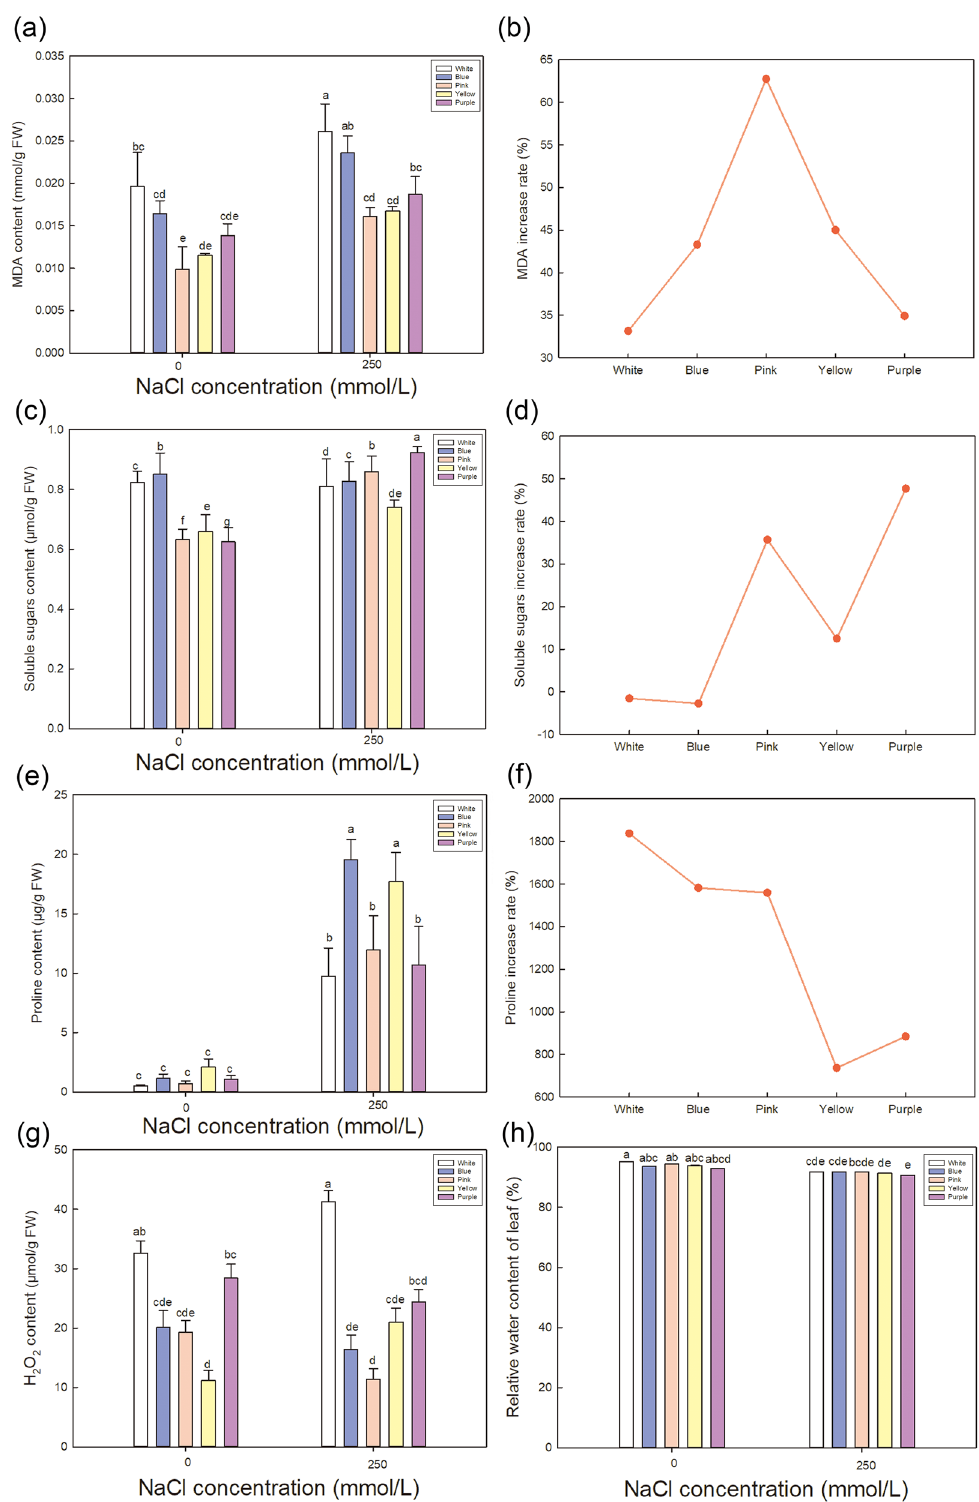
Figure 6. Effect of NaCl stress on MDA, soluble sugars, proline contents, H 2 O 2 and relative water content in the leaves of five varieties of Limonium sinuatum . Contents of MDA ( a ), soluble sugars ( c ), proline ( e ), H 2 O 2 ( g ) and relative water content ( h ) of leaves under control and NaCl treatment in different varieties. The data are means ± SD of five replicates. Different letters indicate significant differences between two groups at P = 0.05 using Duncan’s test with SPSS. The increase rate of MDA ( b ), soluble sugars ( d ) and proline ( f ) are calculated using (value under NaCl treatment—value under control)/value under control ×